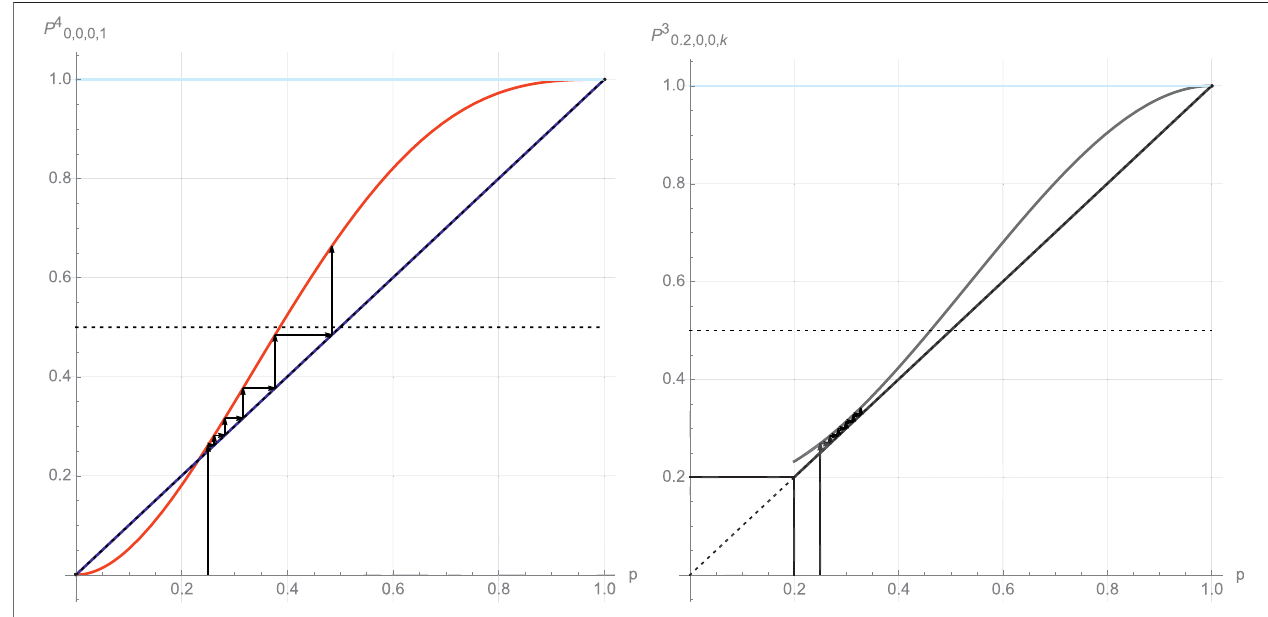
FIGURE 2 | Left: evolution of the proportion of A support P { 4 } 0 , 0 , 0 , 1 ( p ) as a function of p . The arrows show the minority spreading starting from an initial support p (cid:2) 0 . 25. Right: evolution of the proportion of A support P { 3 } 0 . 2 , 0 , 0 , k ( p ) as a function of p . The arrows show the minority spreading starting from an initial support p (cid:2) 0 . 25.